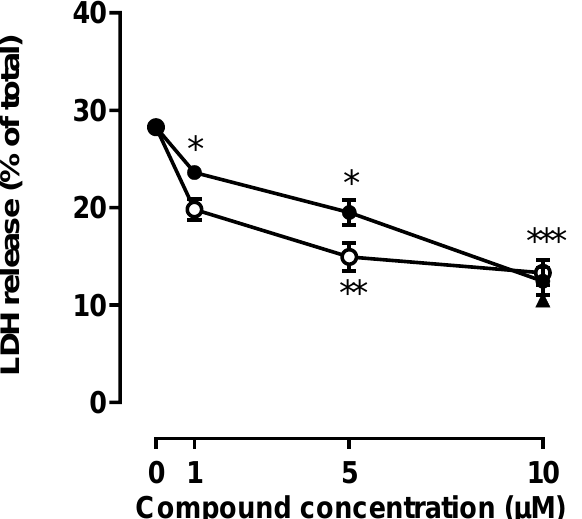
Figure 1. Phosphorous dendrimers prevent NMDA-mediated excitotoxicity. Neurons were treated with the indicated concentration of phosphorous dendrimers G3 (open circles), G4 (closed circles), or MnTBAP (10 µ M; closed triangle) for 1 h; and then NMDA (150 µ M) was added and incubation continued for another 24 h. LDH activity was determined as indicated in the Materials and Methods section. Zero concentration represents net (stimulated–basal) NMDA-induced LDH release in the absence of any other treatment. The data represent the mean ± the s.e.m. of 6 to 12 independent experiments. * p < 0.05, ** p < 0.01, and *** p < 0.001 when compared to NMDA-treated cells.